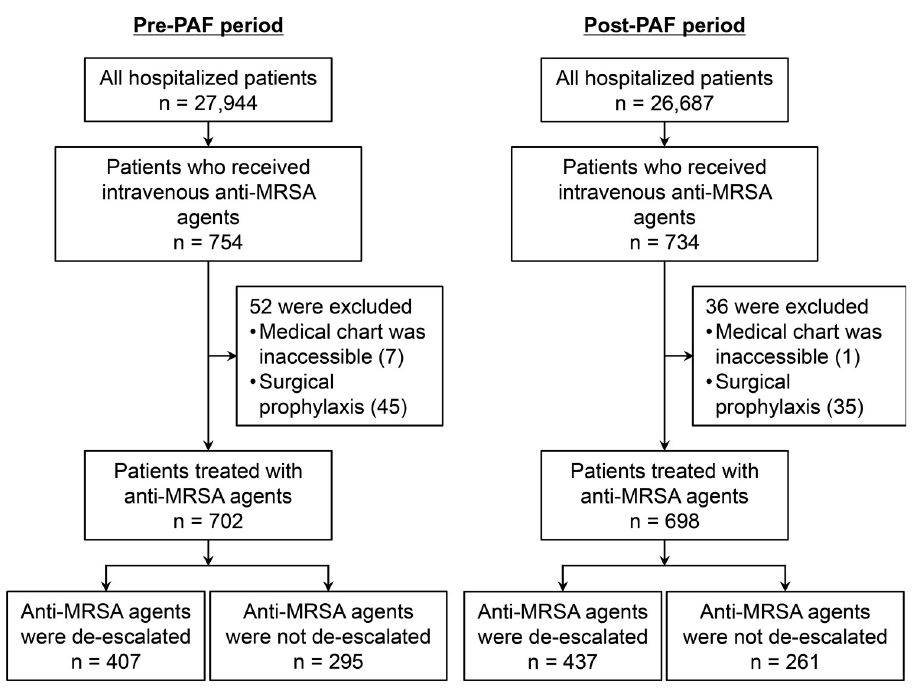
Fig 2. Flow chart of the selection of patients included in this study.